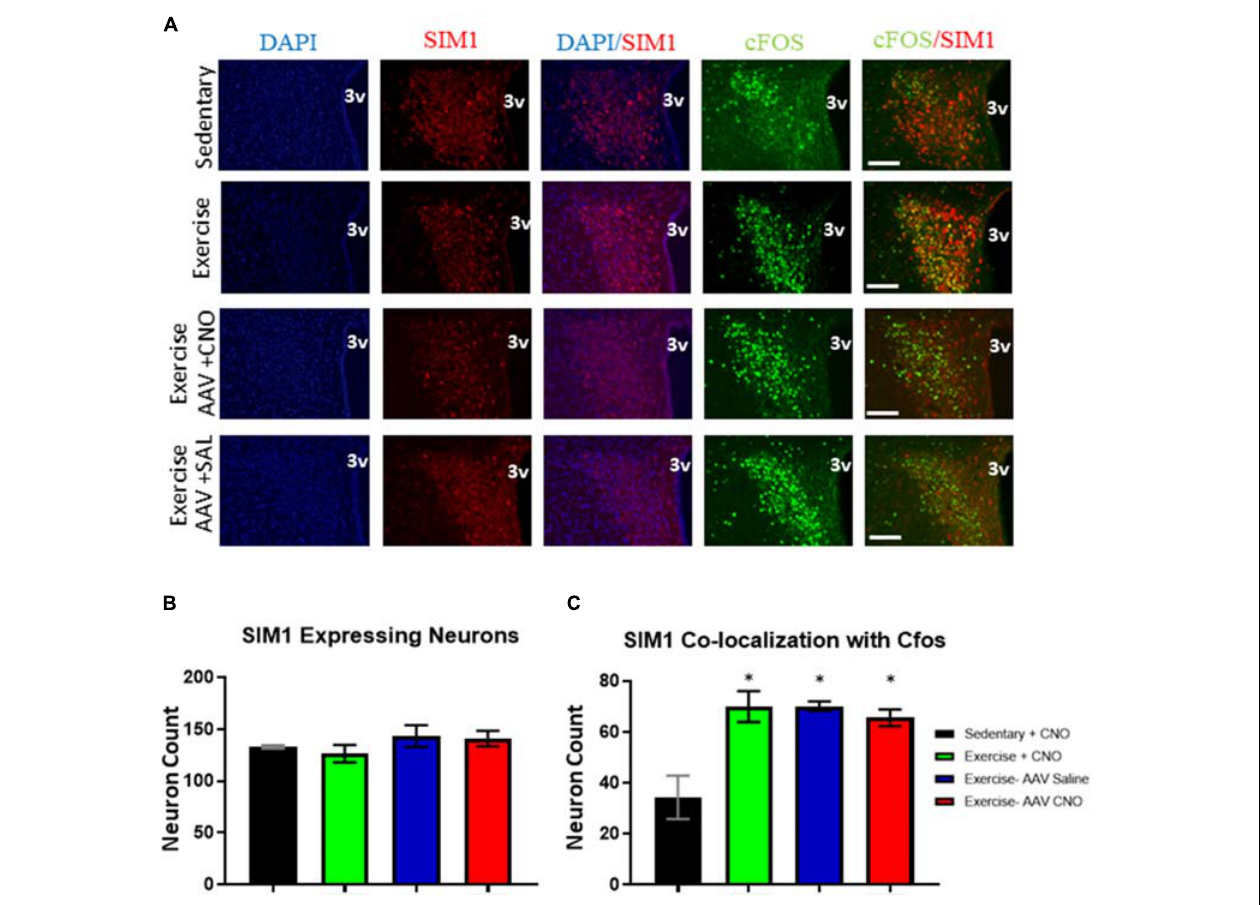
FIGURE 6 | Acute exercise induces PVN SIM1 expressing neuronal activation independent of ARC AgRP / NPY neurons. (A) Immunofluorescence of SIM1-positive and cfos-expressing cells in the PVN from the sedentary, exercise, AAV CNO, and AAV Saline groups immediately after a bout of acute exercise. 3V = third ventricle; scale bars represent 50 µ M. (B) Quantification of SIM1-positive cells in the PVN among the four groups. (C) Quantification of cfos colocalization with SIM1-positive cells in the PVN from the sedentary, exercise, AAV CNO, and AAV Saline groups immediately after a bout of acute exercise. 3V: third ventricle, scale bars represent 50 µ m. Bar graphs show Mean + SEM. ( N = 6 from 3 male mice per group), * indicates p < 0.05 vs. sedentary